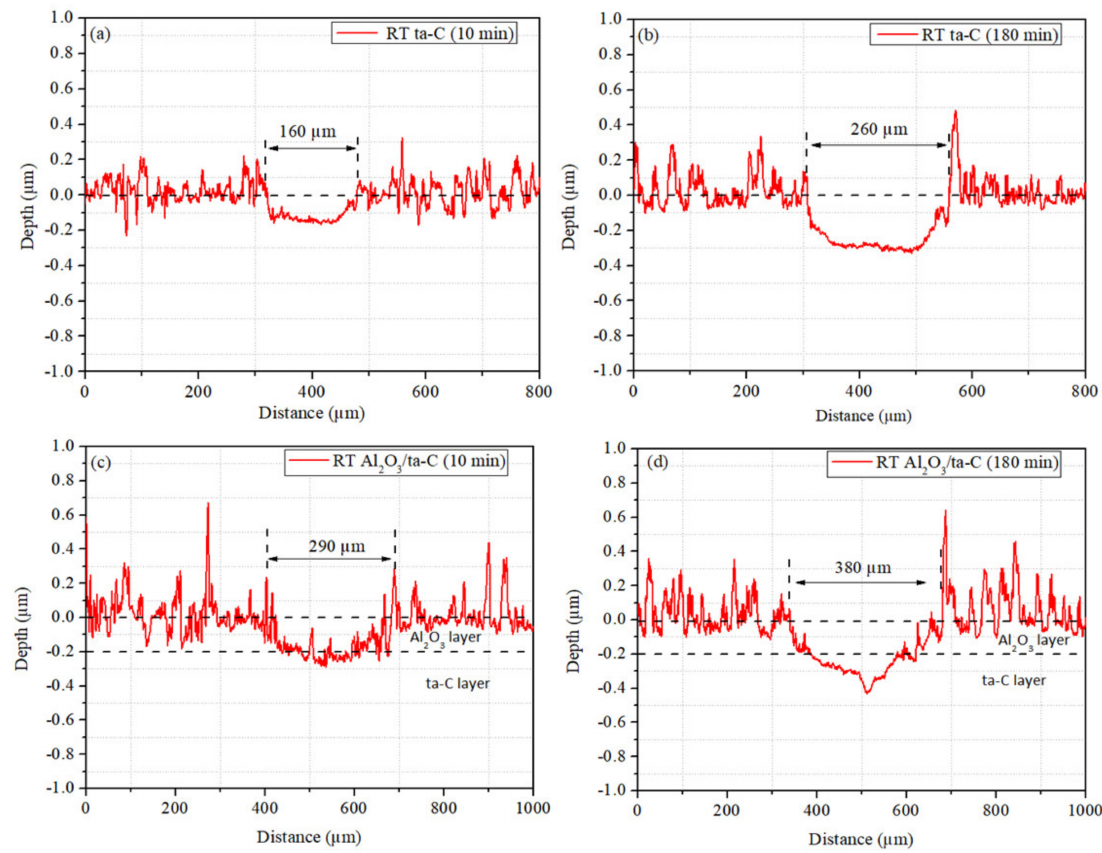
Figure 3. Depth profiles of wear scars observed on the ta-C and Al 2 O 3 /ta-C coatings after the sliding tests for ( a , c ) 10 min and ( b , d ) 180 min at RT.